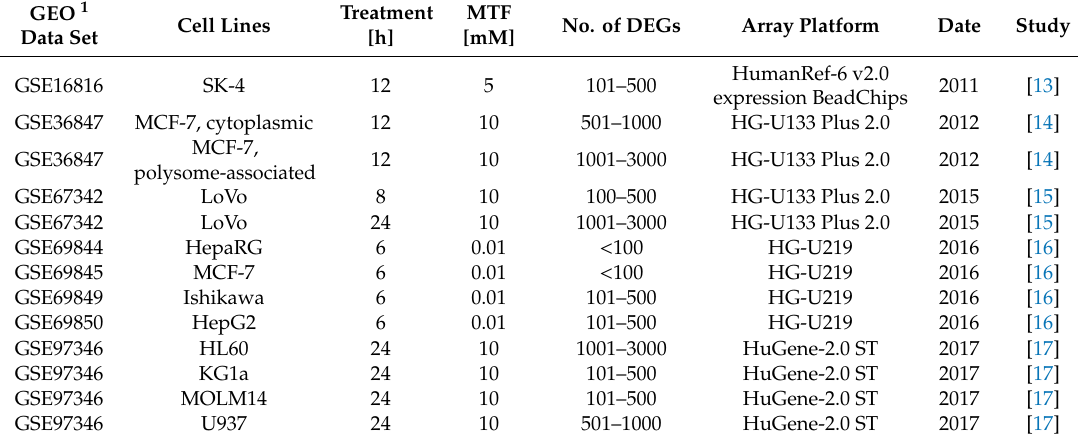
Table 1. Microarray studies on MTF in vitro application included in the meta-analysis.